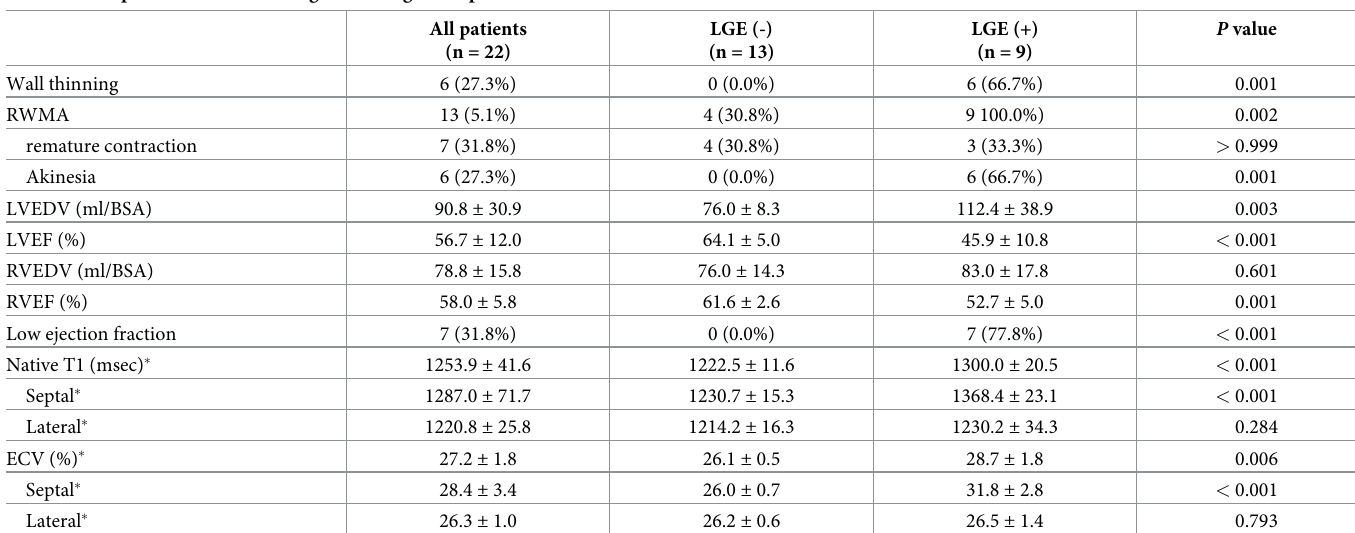
Table 2. Comparison of CMR findings according to the presence of